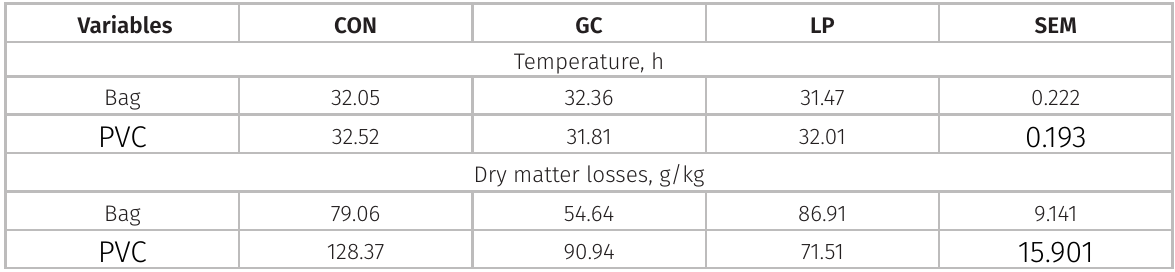
Table VI. Effects of additives and silo type on seven-day aerobic stability of pearl millet silage. Variables